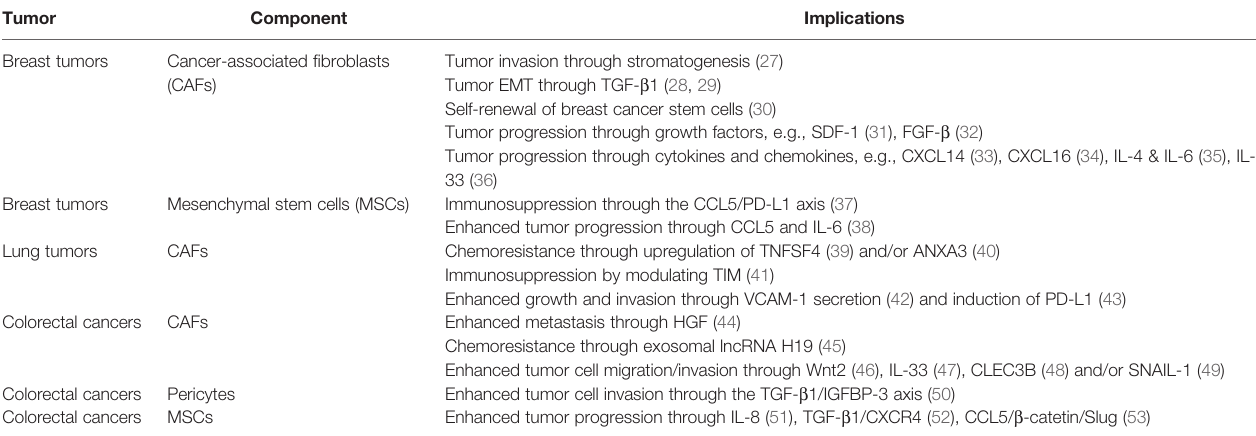
TABLE 1 | Examples of TME ecosystems and their implications in the progression of three signi fi cant cancers: breast, lung and colorectal. Tumor Component Implications Breast tumors Cancer-associated fi broblasts